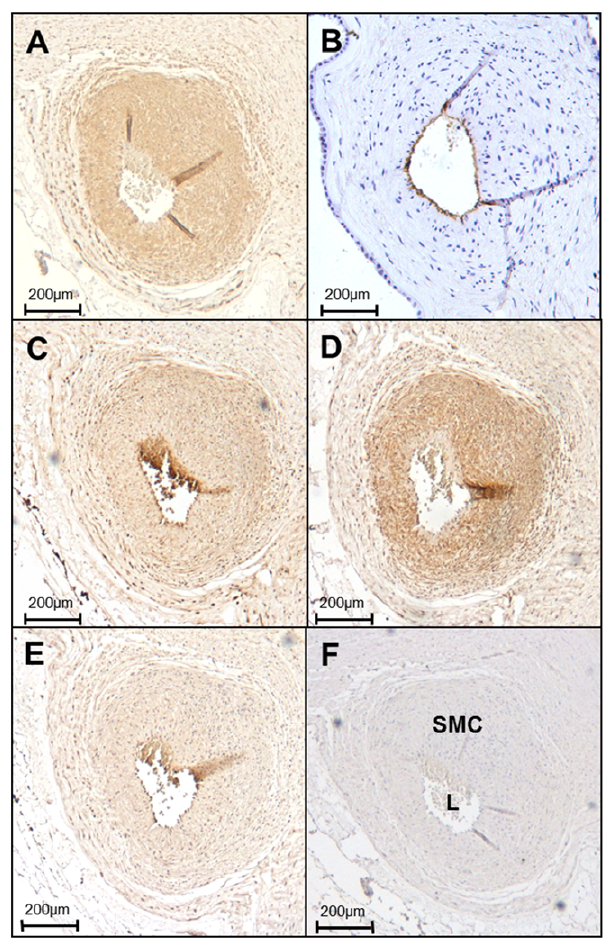
Figure 2. Phenotype characterisation of CPASMCs. Representa- tive examples of immunohistochemistry ( A ) a -smooth muscle actin ( a - SMA), ( B ) CD31 ( C ) myosin-heavy chain-2 (MHC-2) ( D ) h-caldesmon, ( E ) non-muscle myosin heavy chain-B (NMMHC-B), and ( F ) negative control; non-immune IgG. Positive immunostaining (DAB; brown) and nuclei (haematoxylin; blue). SMC; smooth muscle cell, L;